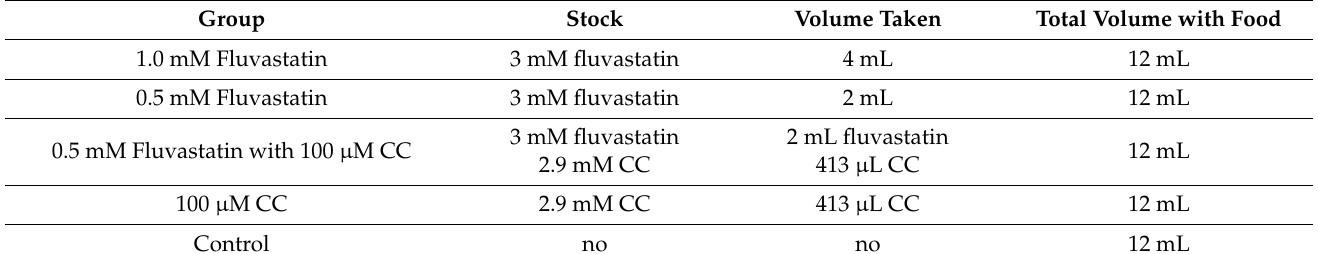
Table 4. Feeding pattern for fluvastatin group, fluvastatin with CC group, CC group and control groups.